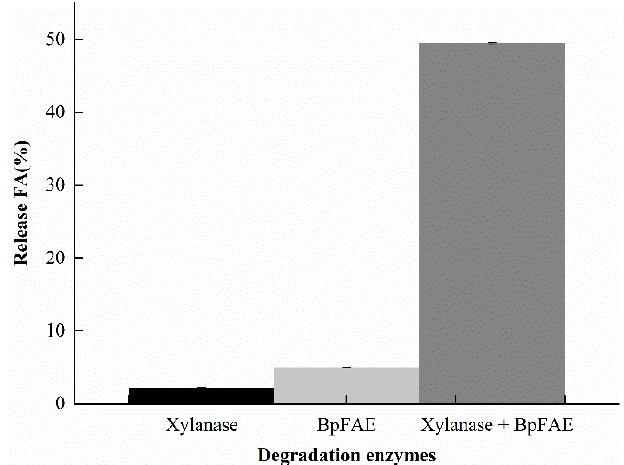
Figure 5. Production of FA from DSWB using different enzymes.